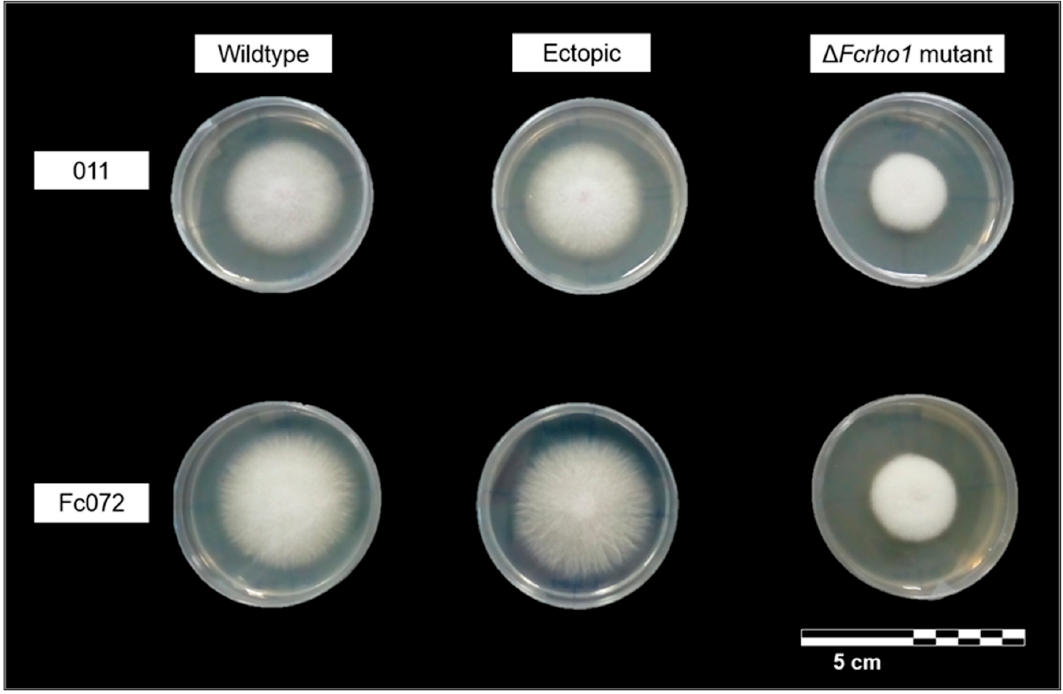
Figure 2. Colonies of F. circinatum growing in PDA (Appendix A) after one week of culturing. Wildtype (011 and Fc072) and ectopic strains (011ect5 and Fc072ect2) showed homogeneous growth and hairy appearance of colony. Mutant strains ( Δ Fcrho1 011 and Δ Fcrho1 Fc072) showed lower growth rates and foamy macroscopic appearance.